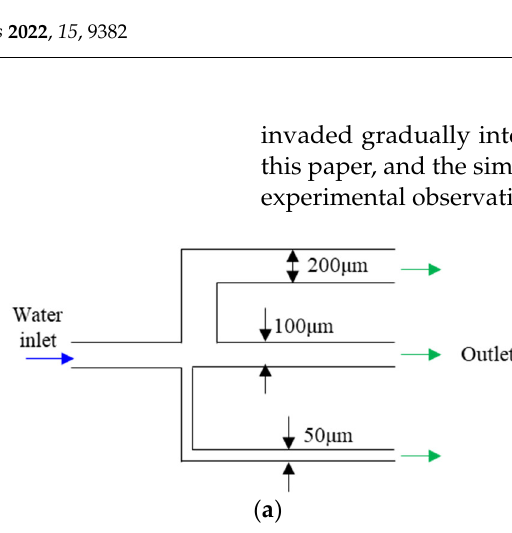
Figure 1. Illustration of the geometries of the fracture models used for validating the simulation method. ( a ) Gerami model; ( b ) Mansour model.